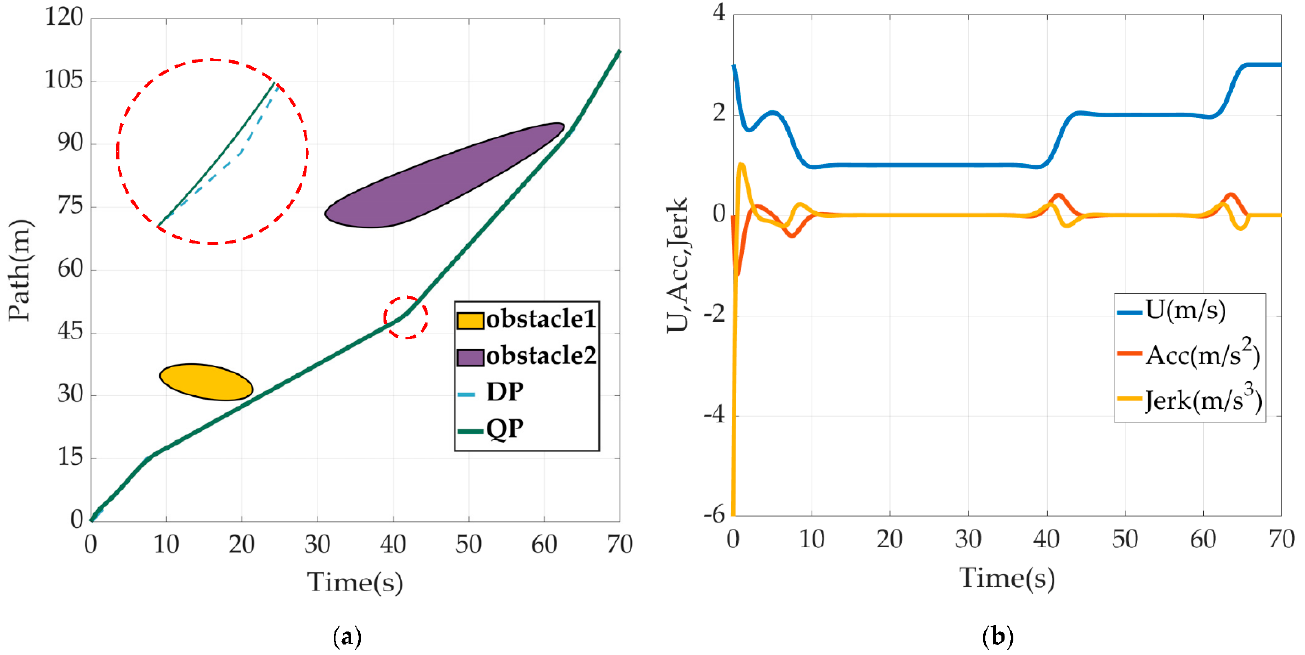
Figure 5. Velocity planning based on ST graph. ( a ) Results of DP & QP; ( b ) Reference input values of RVC generated from